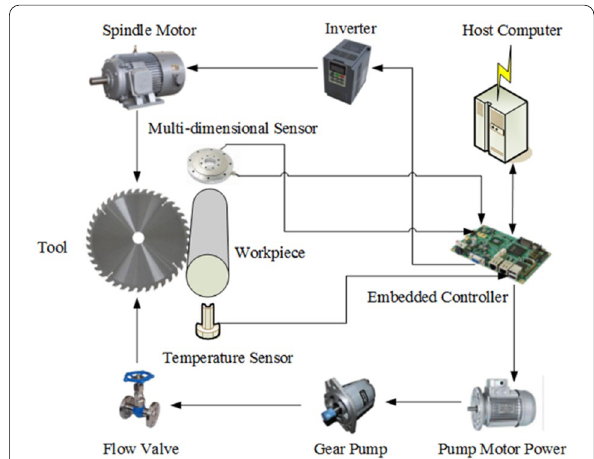
Figure 4 An embedded muti-loop parallel system of processing-measuring integrated control